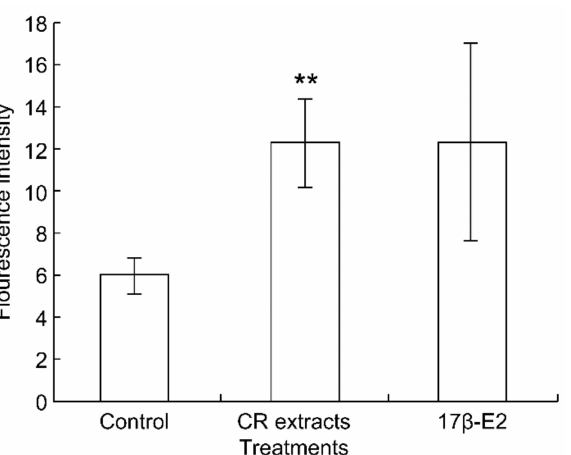
Figure 3. Effects of Black Cohosh extract (CR extracts) on estrogen receptor levels in MCF-7 cells. In comparison with the control group, the results of t test are expressed as follows: ** p < 0.01. Reprinted from Liu, Z.P.; Yu, B.; Huo, J.S.; Lu, C.Q.; Chen, J.S. Estrogenic Effects of Cimicifuga racemosa